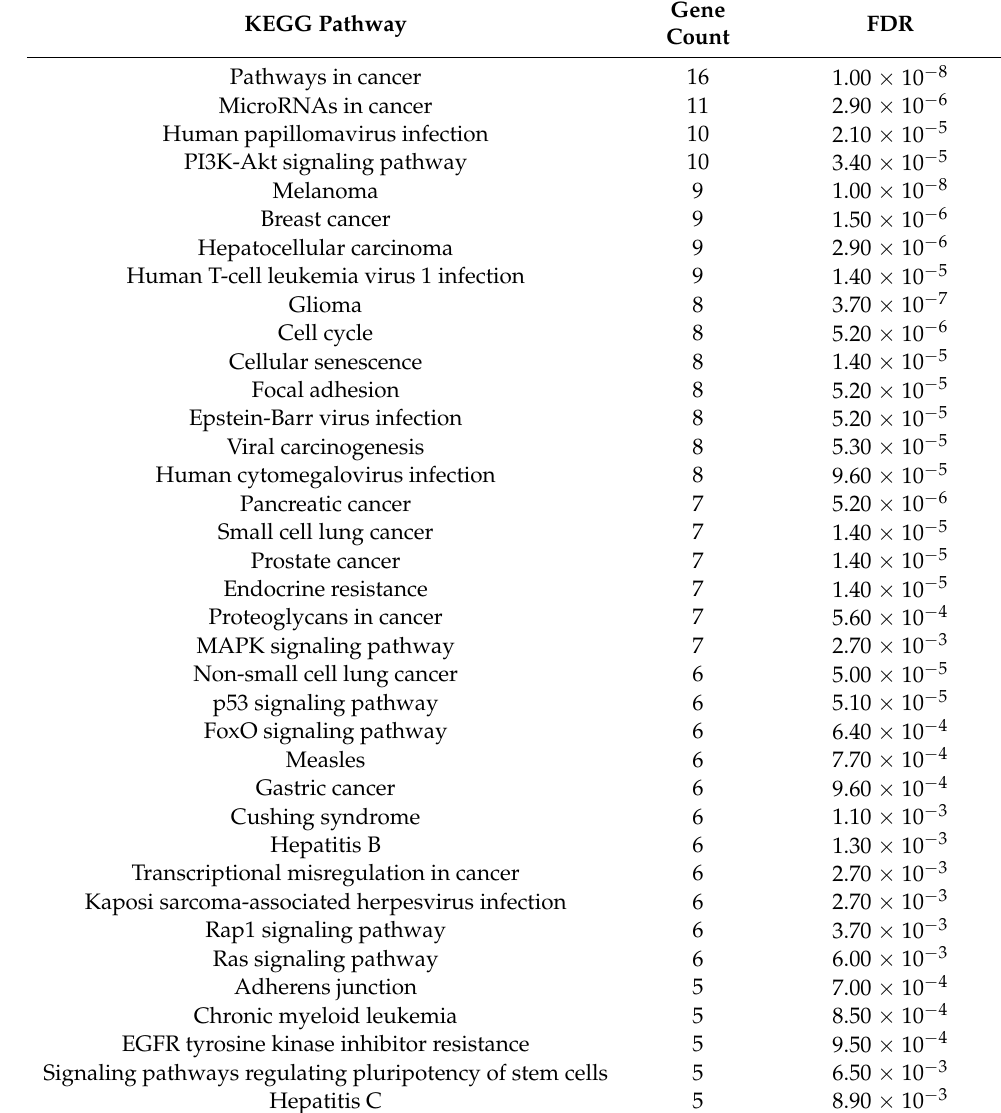
Table 4. KEGG pathway implications of the shared target genes downstream of the CRC exosomal ncRNAs axis. Minimum gene count = 5. FDR cut-off =